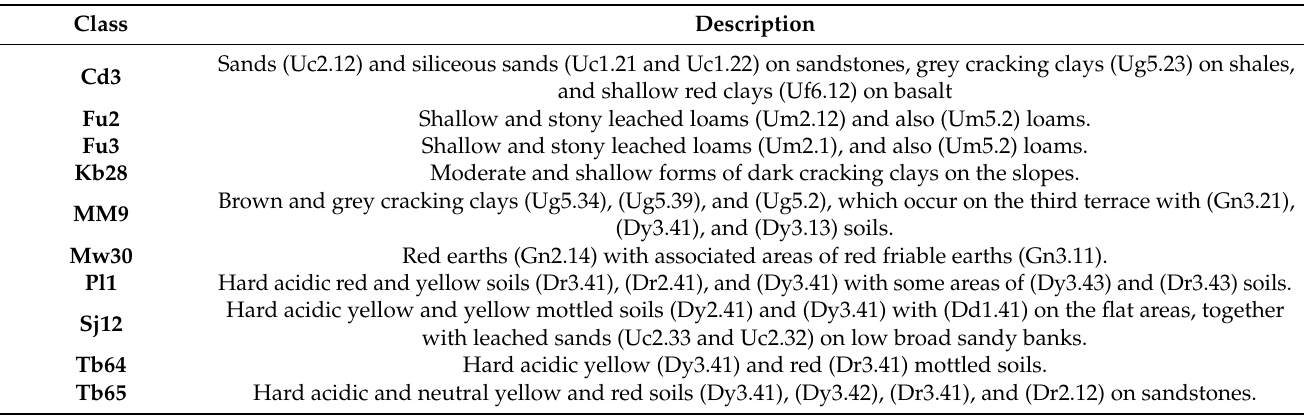
Table 2. Soil contents and classes in the study